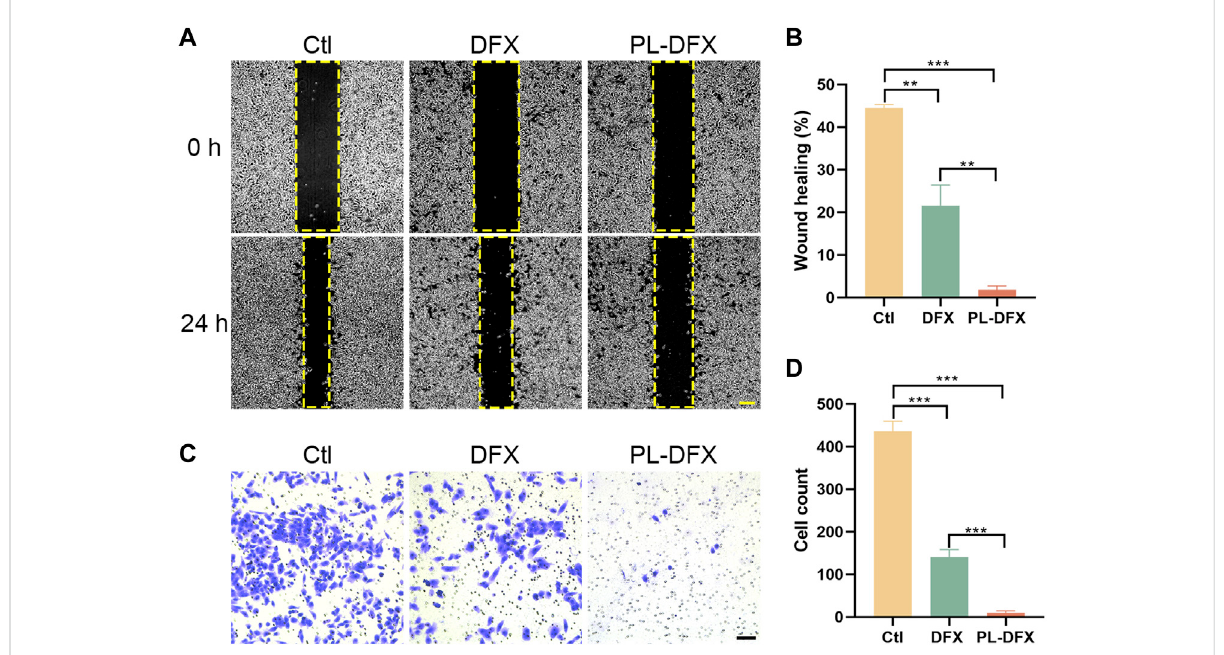
FIGURE 5 Inhibitionofmigrationandinvasion invitro . (A,B) MicroscopicimageandstatisticalchartofwoundhealingassayinHGC-27incubatedwithDFX (12.5 μ M) and PL-DFX (12.5 μ M) for 24 h. Scale bar: 200 μ m. (C,D) Microscopic image and statistical chart of transwell invasion assay in